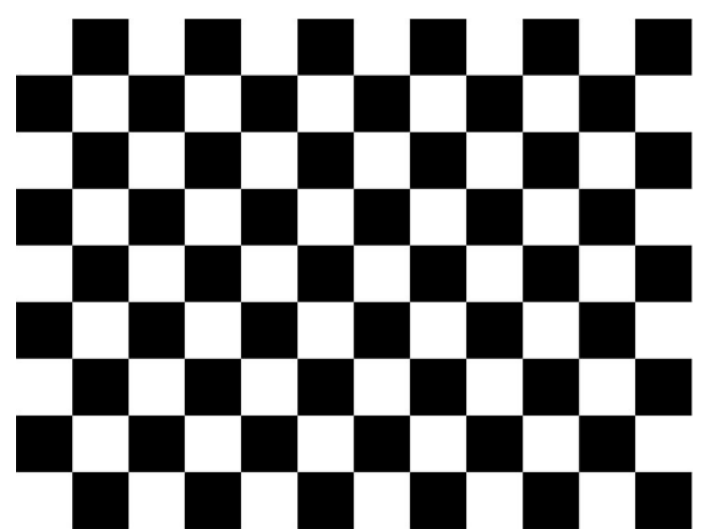
Figure 3. Camera calibration based on chessboard structural geometry.